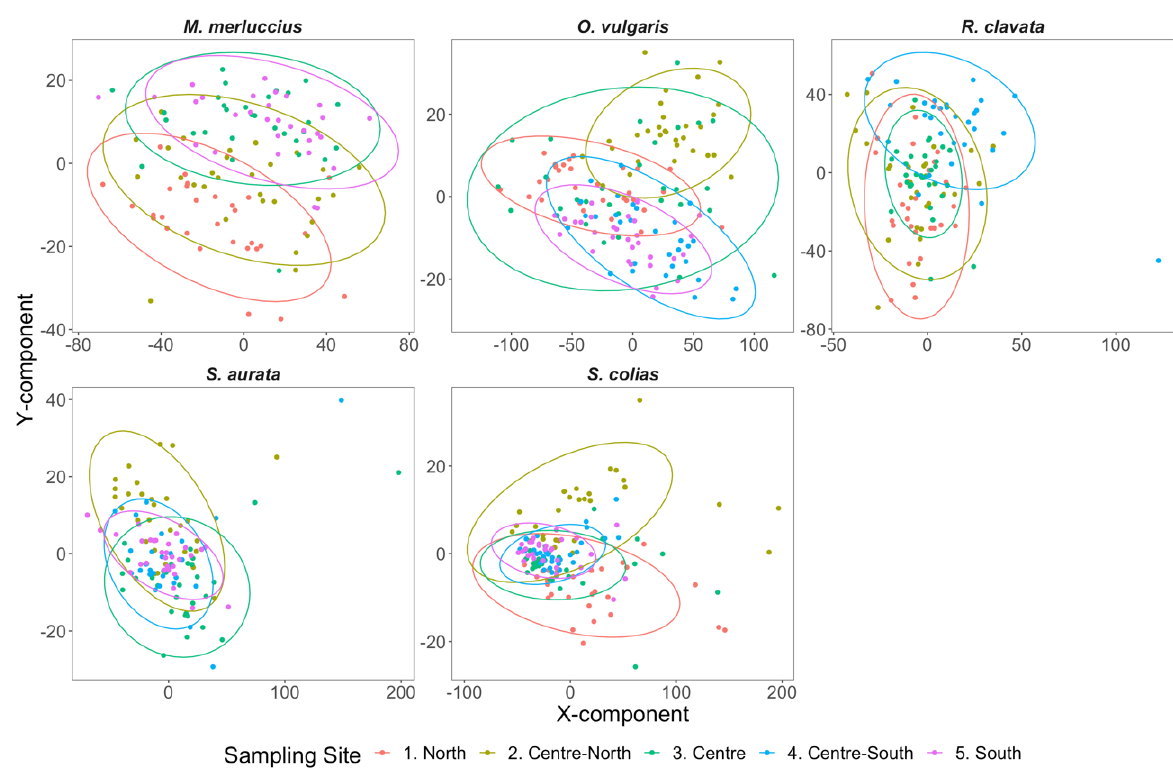
Figure 5. Partial least-squares discriminant analysis (PLS-DA) 3D plots of the first three PLS-DA components having as input the processed (Savitzky–Golay first-order differentiation filter) X-ray fluorescence reflectance spectra of Merluccius merluccius , Octopus vulgaris , Raja clavata , Sparus aurata, and Scomber colias samples collected along the Portuguese coast (average N = 30 per site per species).